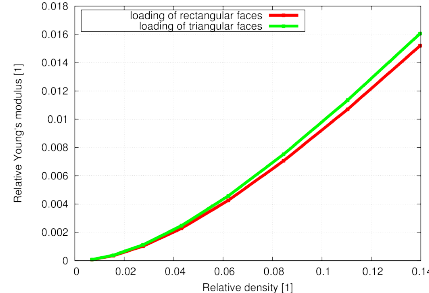
Figure 5. Relative Young’s modulus of RVE of the structure plotted against its relative